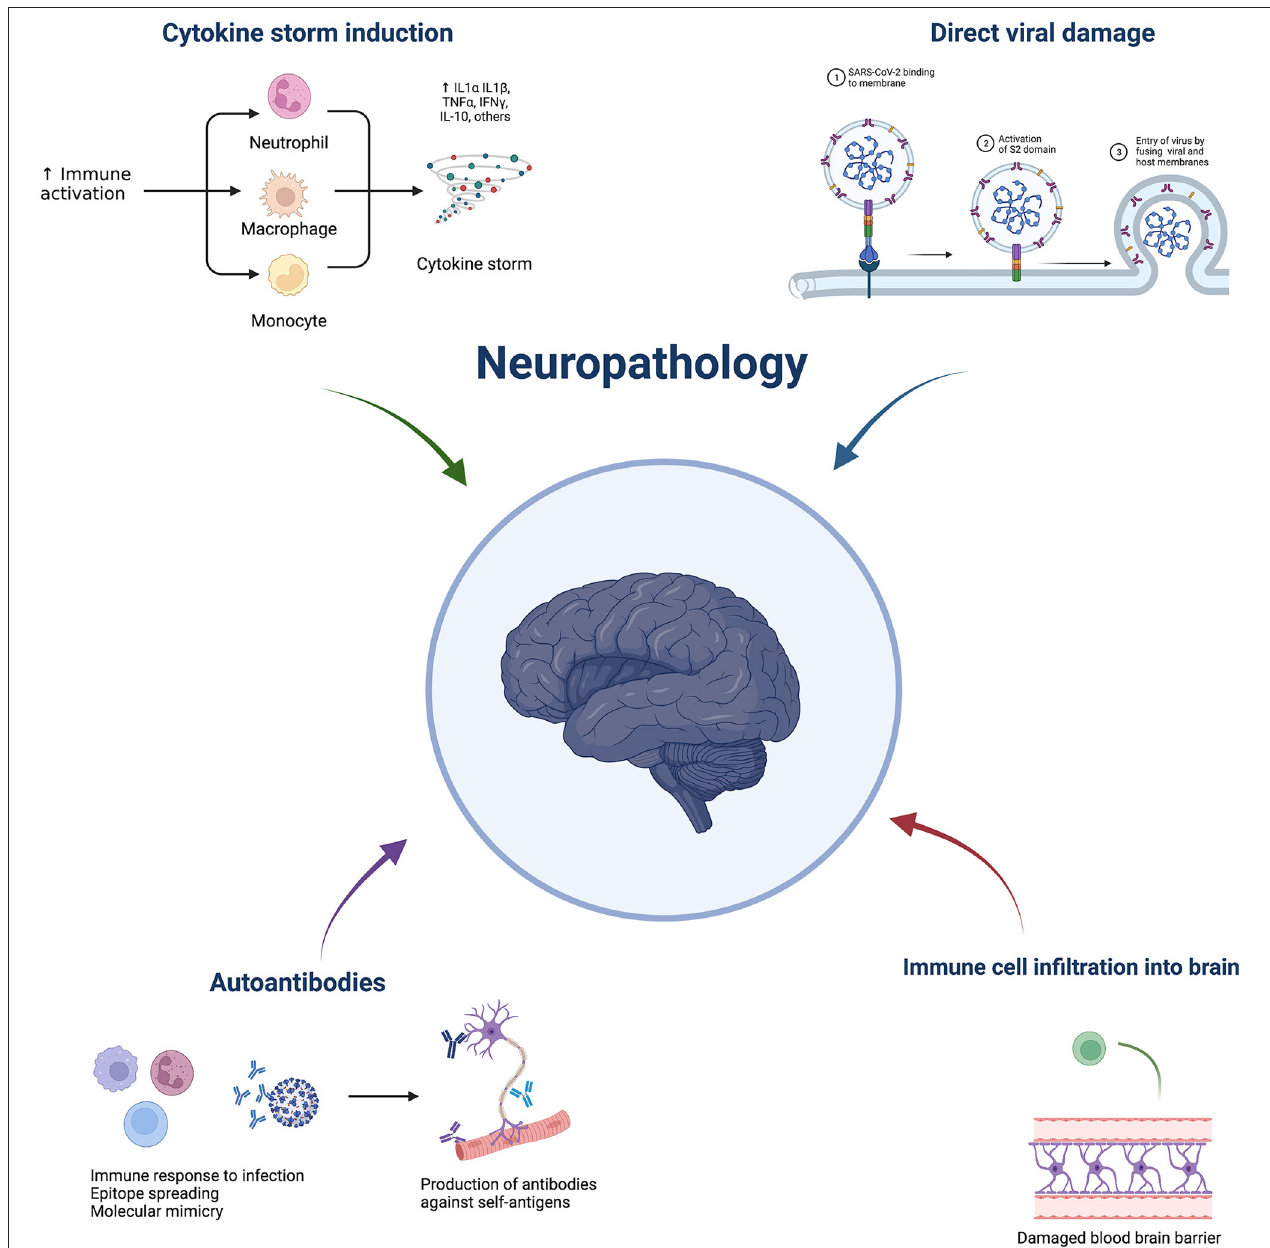
FIGURE 1 | Overview of potential mechanisms underlying COVID-19 neuropathology. Made by